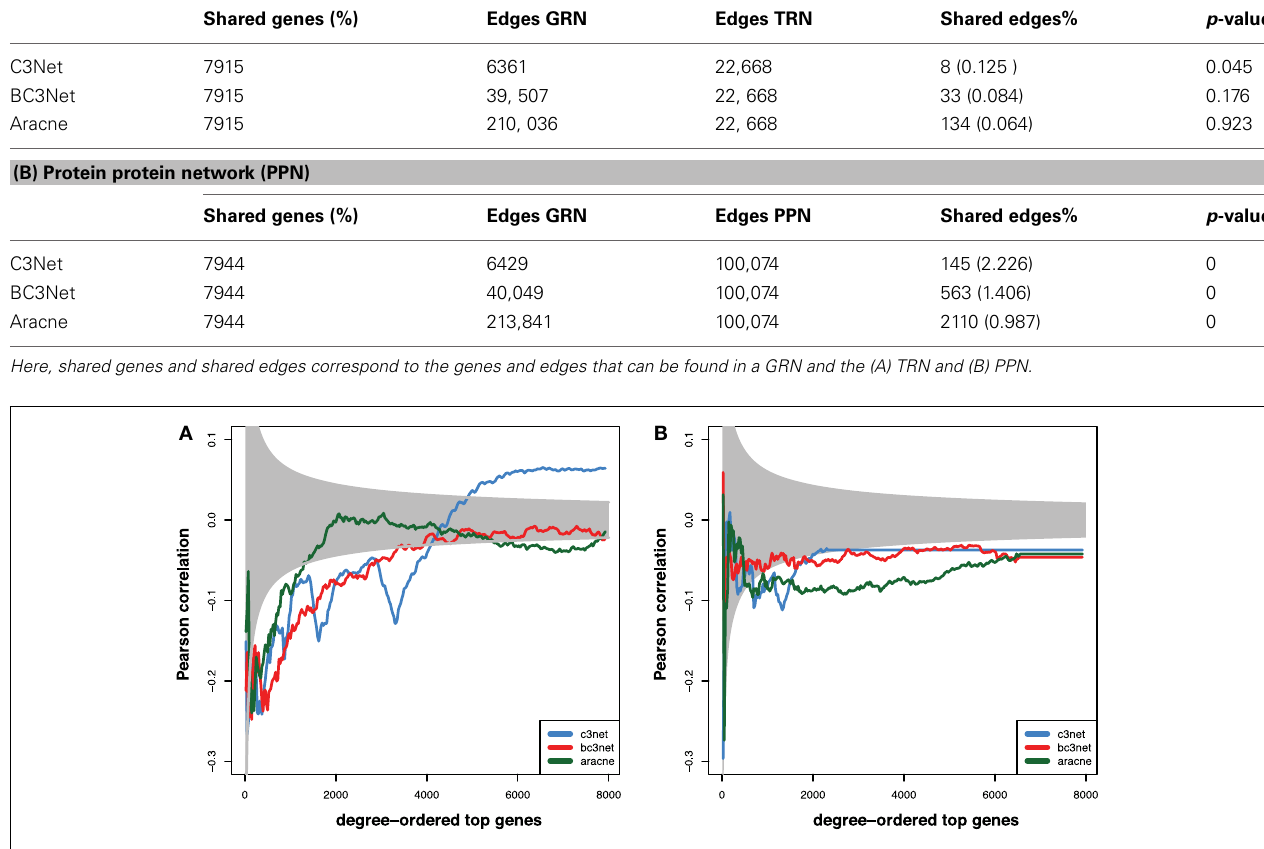
Table 3 | Network comparison between the 3 B-cell lymphoma GRNs and the (A) TRN and (B) PPN. (A) Transcriptional regulatory network (TRN)